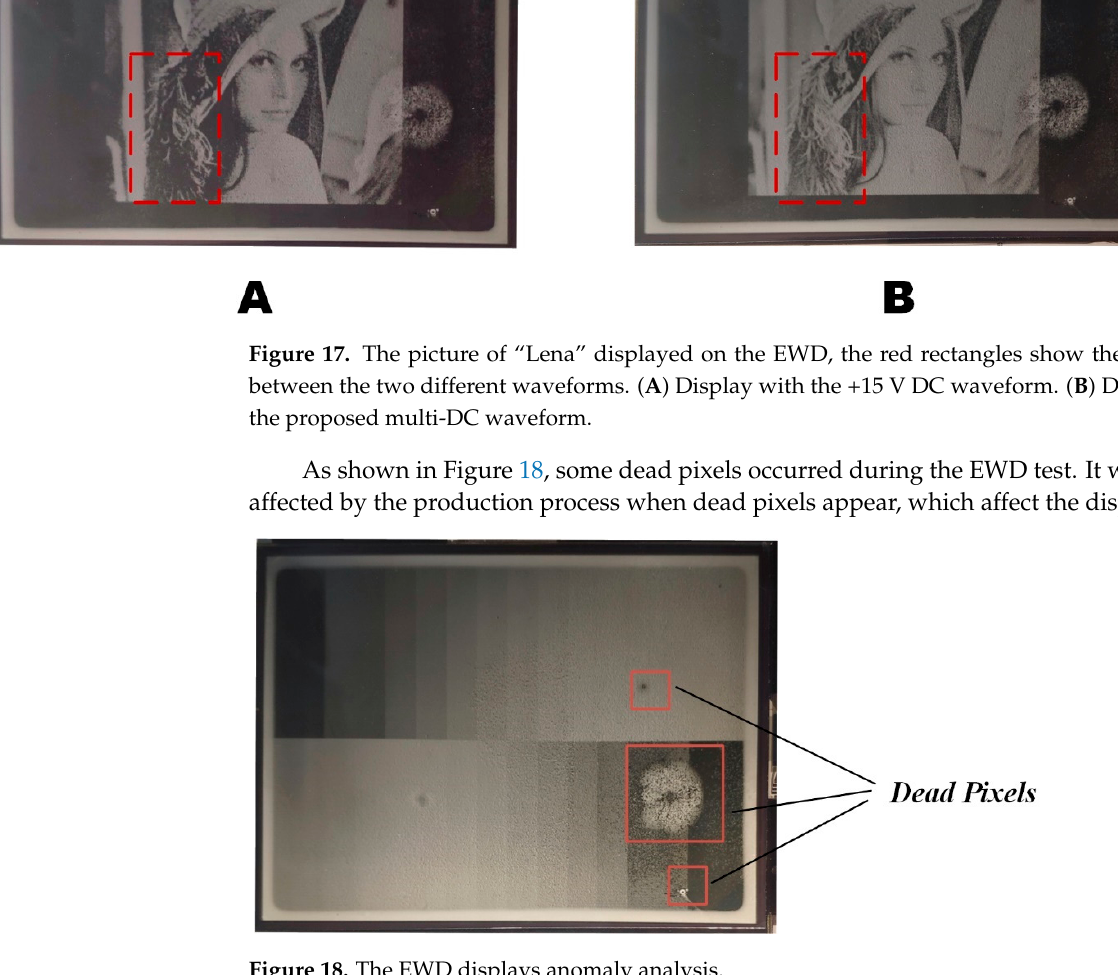
Figure 18. The EWD displays anomaly analysis.